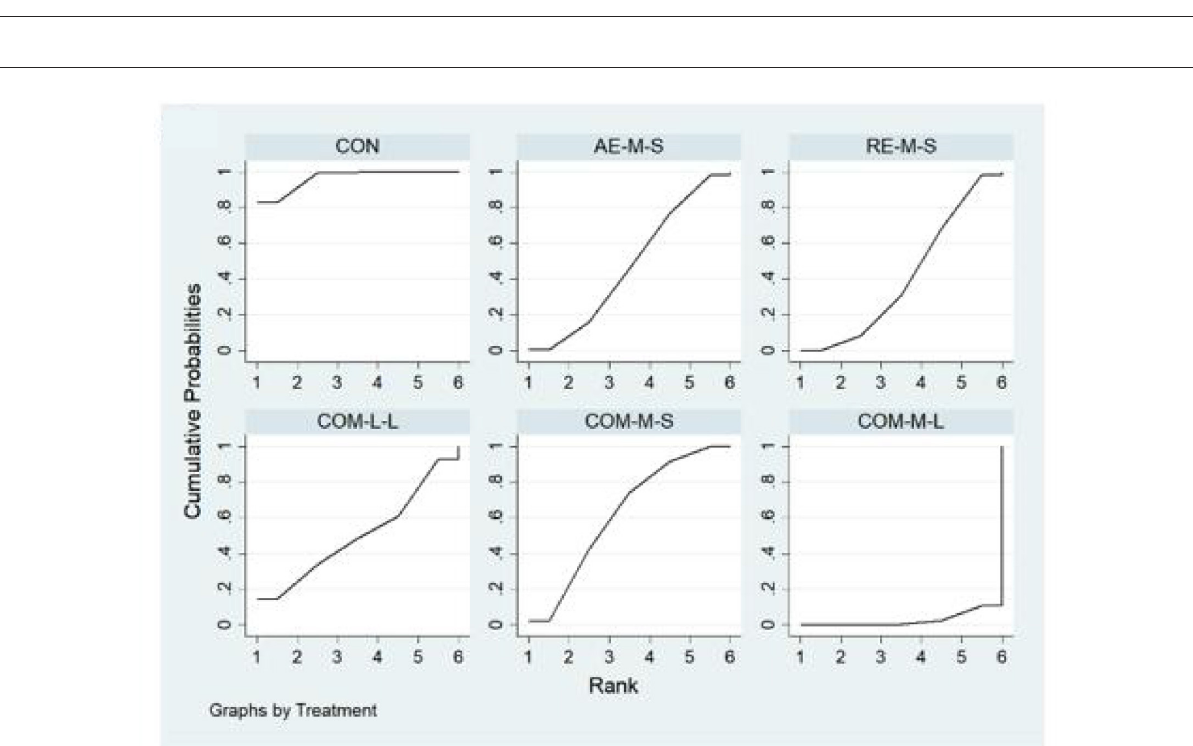
FIGURE6 The surface under the cumulative ranking curve (SUCRA) ranking chart for